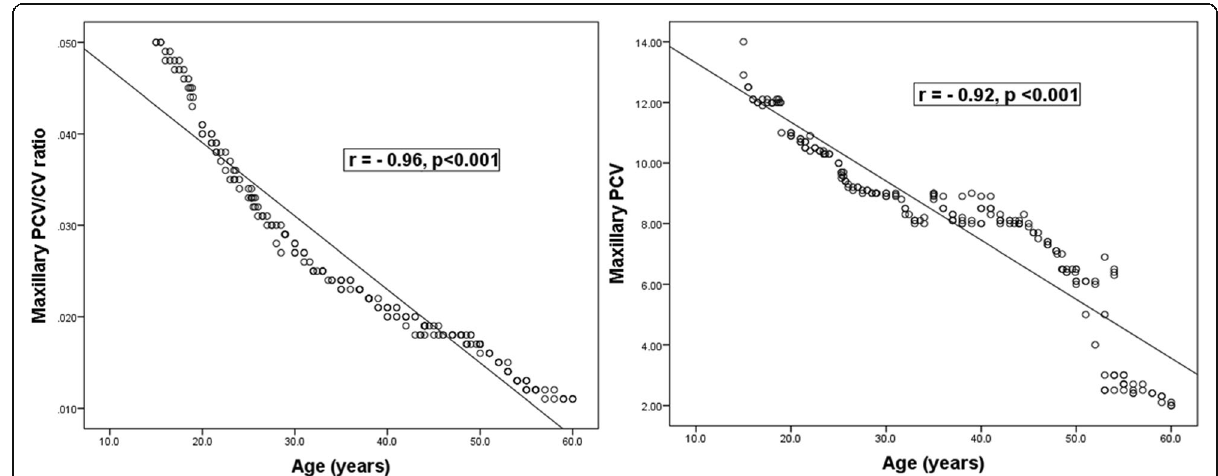
Fig. 3 Correlation of maxillary PCV and PCV/CV ratio with the chronological age of the studied subjects ( N =